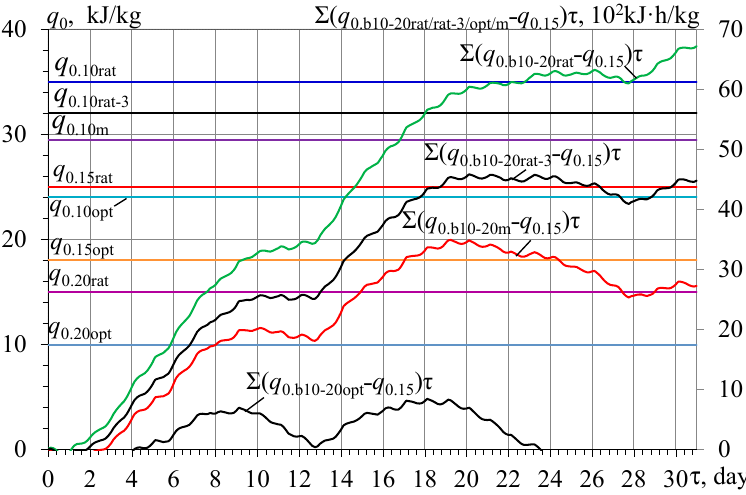
Figure 10. Summarized values of the excessive available accumulated refrigeration energy over needed values for cooling ambient air to t a2 = 15 °C based on the rational Σ ( q 0.b10-20rat − q 0.15 ) τ , optimum Σ ( q 0.b10-20opt − q 0.15 ) τ , their middle Σ ( q 0.b10-20m − q 0.15 ) τ values, and the rational value Σ ( q 0.b10-20rat-3 − q 0.15 ) τ decreased by 3 kJ/kg: q 0.b10-20rat = q 0.10rat − q 0.10-20 ; q 0.b10-20opt = q 0.10opt − q 0.10-20 ; q 0.b10-20m = q 0.10m − q 0.10-20 ; q 0.b10- 20rat-3 = q 0.10rat-3 − q 0.10-20 ; q 0.10m = ( q 0.10rat + q 0.10opt )/2; q 0.10rat-3 = q 0.10rat − 3 kJ/kg; q 0.10-20 = q 0.10 − q 0.20 .